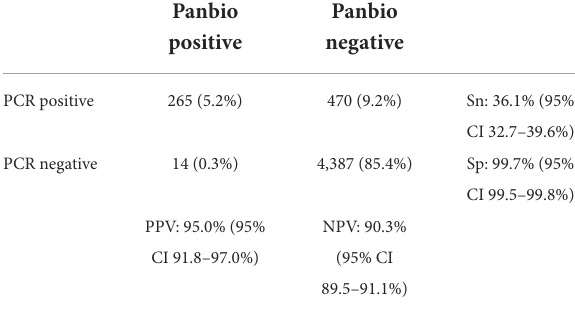
TABLE 3 Analytic performance of Panbio, all tests